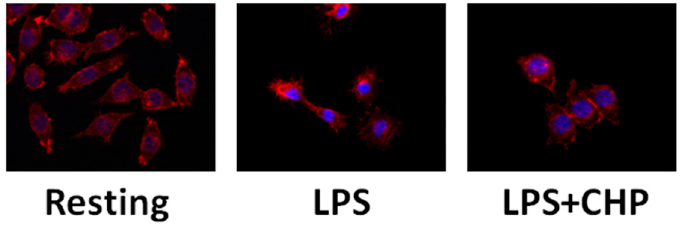
Figure 2. Effects of cyclo(His-Pro) (CHP) on glia morphology. BV2 microglial cells were pre-treated with 50 μ M cyclo(His-Pro) (24 h) prior to 10 μ g/mL lipopolysaccarde (LPS) (24 h). Morphology was assessed by TRIC-labelled phalloidin staining (red) and nuclei were counterstained with DAPI (blue). Magnification: 20×.